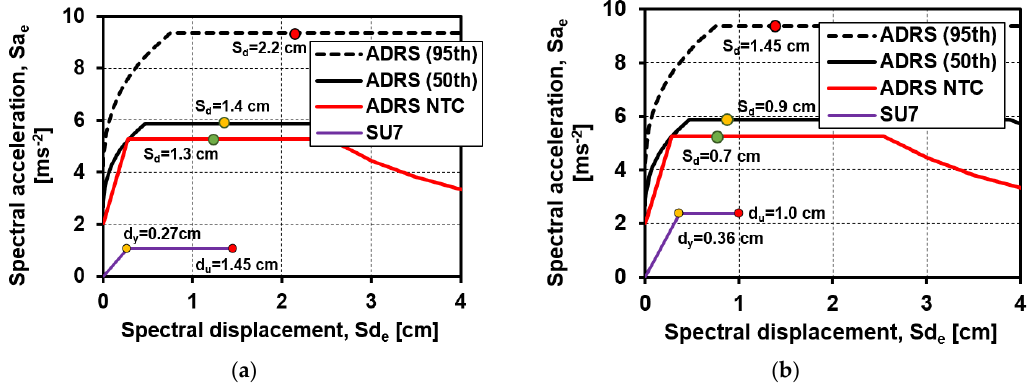
Figure 15. Seismic checks of the head SU in the ADRS plane in ( a ) X and ( b ) Y directions, considering the worst mechanical analysis case; ( a ) Head SU, X dir.; ( b ) Head SU, Y dir.